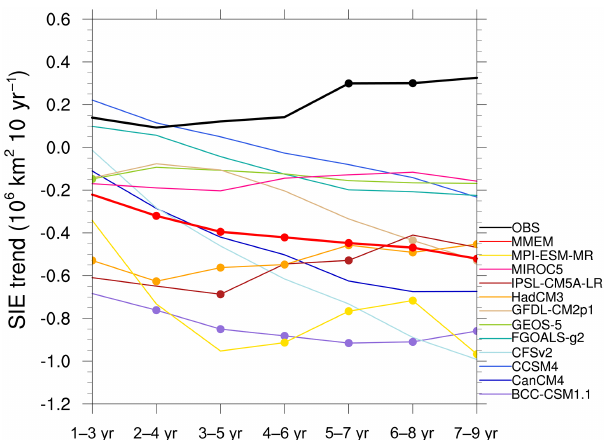
Figure 9. The predicted trends (slope of a linear regression) of September Antarctic sea ice extent (SIE) anomalies as a function of the lead time after applying a 3-year average. The dots represent the trends exceeding 95% confidence